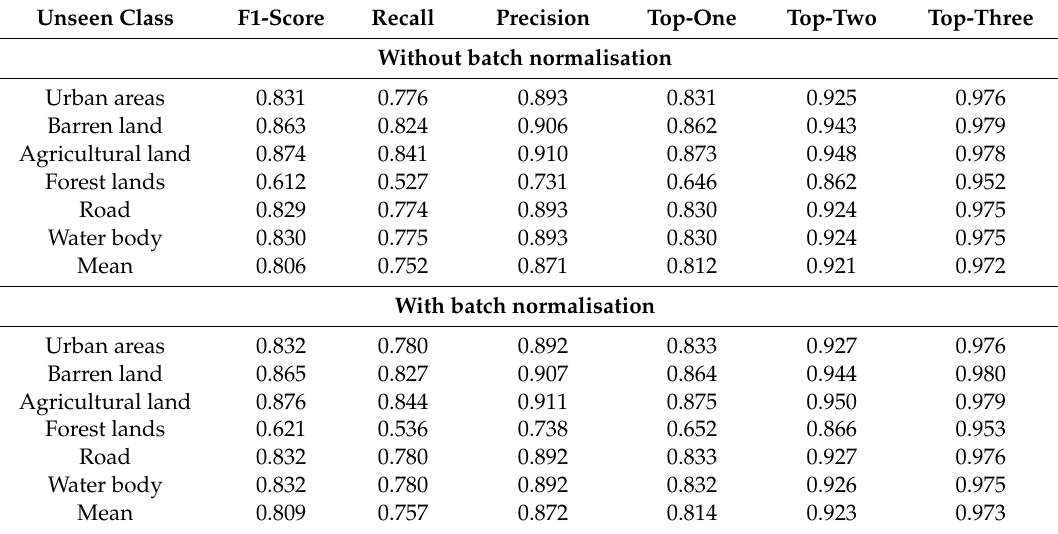
Table 7. Accuracy of the model without and with batch normalisation for the training area. Unseen Class F1-Score Recall Precision Top-One Top-Two Top-Three Without batch